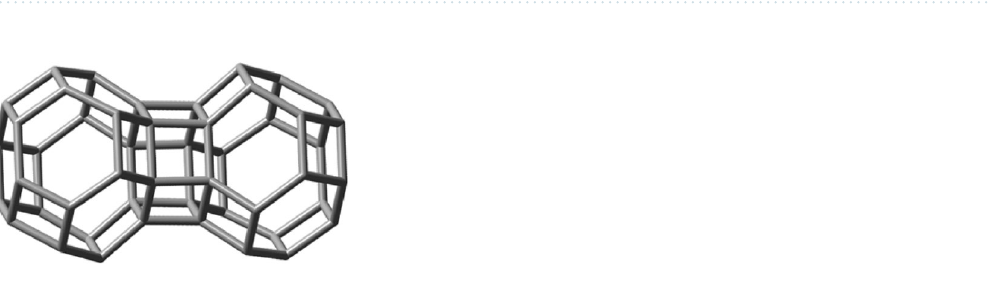
Figure 12. A solid view of the 3D carbon allotrope formed by fusions of several space filling carbon voxel nuggets 24a containing 252 carbon atoms.